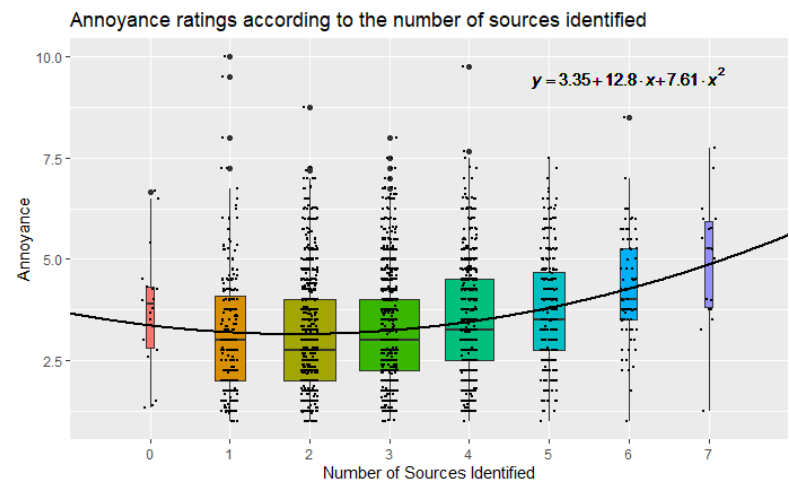
Figure 5. Box plots of the Annoyance scores as a function of the number of sound sources present in the recording (identified by participants), box width represents relative sample size; the N = 8 sound sources group only included two datapoints, and was therefore dismissed (the mean annoyance scores for those is M = 5.0).